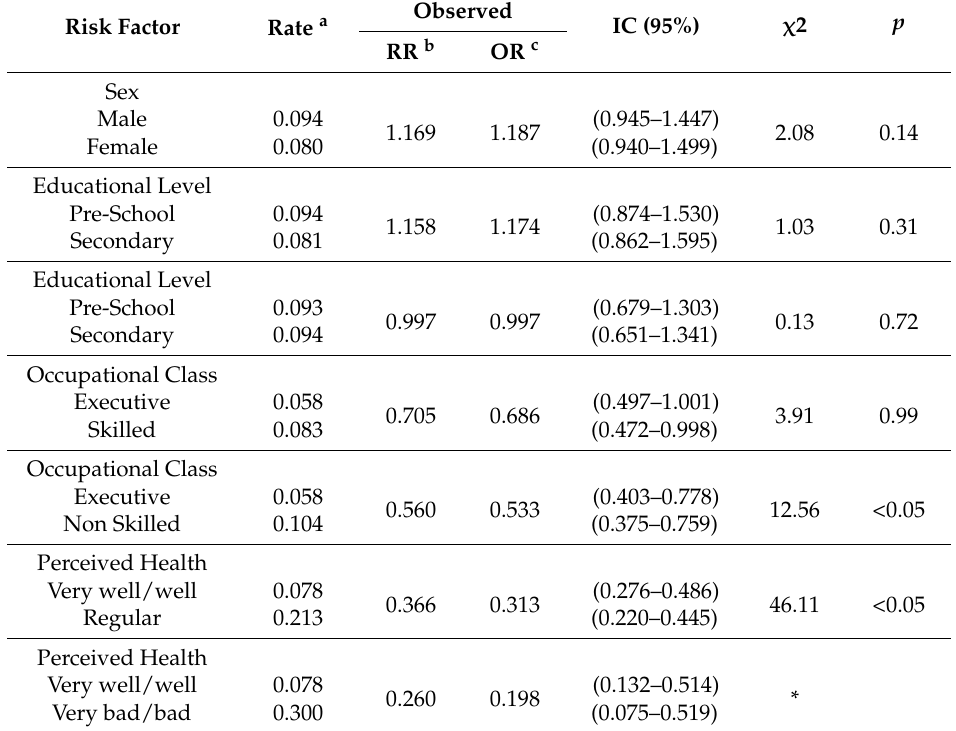
Table 3. Ratios and Odds Ratios depending on the different risk